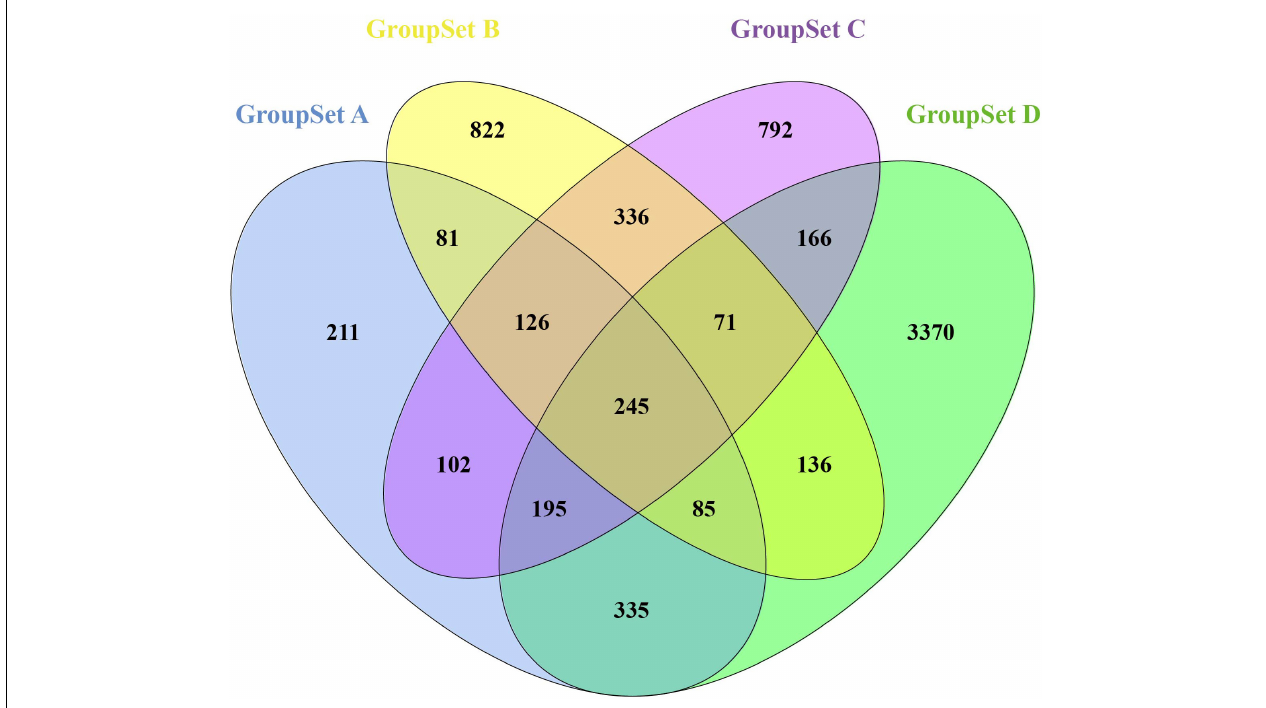
FIGURE 2 | Identification of overlapping DEGs in all four GroupSets. Each colored ellipse in the Venn diagram represents a GroupSet, and the number stands for the number of DEGs in each cross